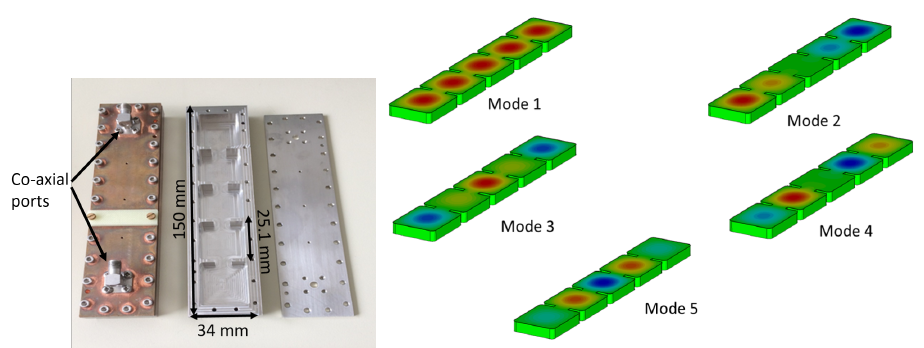
Figure 1 . Left: CAST-RADES cavity after copper coating (closed) and before the copper coating (opened). Right: electric field pattern of the cavity modes [31], where red and blue indicate opposite directions of the electric field. The first mode, in which the electric field in all sub-cavities is parallel to the external magnetic field, couples to the